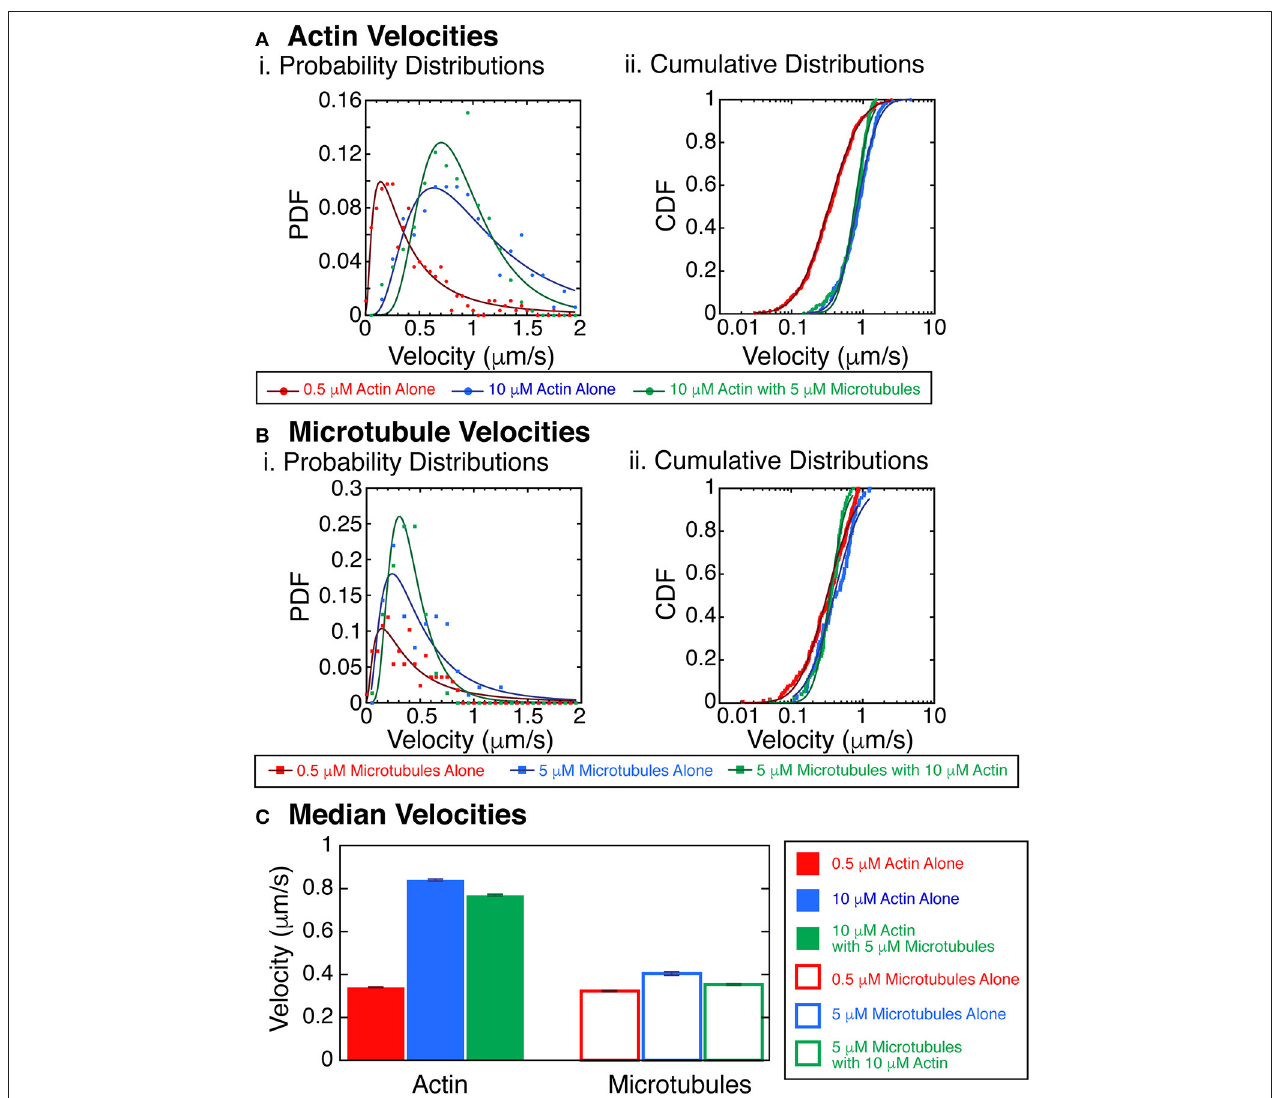
FIGURE 6 | Velocity of actin filaments increases with polymer concentration. (A) Actin velocities with crowding. (i) Probability distribution functions of the velocity of trackable actin filaments gliding in the myosin and kinesin gliding assay at 0.5 µ M without microtubules (red filled circles), 10 µ M without microtubules (blue filled circles), or 10 µ M with 5 µ M microtubules (green filled circles). Fits to the data are lognormal fit equation (Equation 1, Supplemental) for 0.5 µ M without microtubules (dark red line), 10 µ M without microtubules (dark blue line), or 10 µ M with 5 µ M microtubules (dark green line). (ii) Cumulative probability distribution functions of the velocity of trackable actin filaments gliding in the myosin and kinesin gliding assay at 0.5 µ M without microtubules (red filled circles), 10 µ M without microtubules (blue filled circles), or 10 µ M with 5 µ M microtubules (green filled circles). Fits to the data are lognormal fit equation (Equation 2, Supplemental) for 0.5 µ M without microtubules (dark red line), 10 µ M without microtubules (dark blue line), or 10 µ M with 5 µ M microtubules (dark green line). (B) Microtubules velocities with crowding. (i) Probability distribution functions of the velocity of trackable microtubule filaments gliding in the myosin and kinesin gliding assay at 0.5 µ M without actin (red filled squares), 5 µ M without actin (blue filled squares), or 5 µ M with 10 µ M actin (green filled squares). Fits to the data are lognormal fit equation (Equation 1, Supplemental) for 0.5 µ M without actin (dark red line), 5 µ M without actin (dark blue line), or 5 µ M with 10 µ M actin (dark green line). (ii) Cumulative probability distribution functions of the velocity of trackable microtubule filaments gliding in the myosin and kinesin gliding assay at 0.5 µ M without actin (red filled squares), 5 µ M without actin (blue filled squares), or 5 µ M with 10 µ M actin (green filled squares). Fits to the data are lognormal fit equation (Equation 2, Supplemental) for 0.5 µ M without actin (dark red line), 5 µ M without actin (dark blue line), or 5 µ M with 10 µ M actin (dark green line). (C) Median velocities from the fits to the cumulative distribution functions for actin (filled bars) and microtubules (outlined bars). Actin data from 0.5 µ M without microtubules (red filled bar), 10 µ M without microtubules (blue filled bar), or 10 µ M with 5 µ M microtubules (green filled bar). Microtubule data from 0.5 µ M without actin (red filled bar), 5 µ M without actin (blue filled bar), or 5 µ M with 10 µ M actin (green filled bar). Error bars represent the uncertainty of the median velocity fit parameter from Equation 2 (Supplemental). See Supplemental Information for fit equation and Supplemental Tables 5–8 for all fit parameters with uncertainty and goodness of